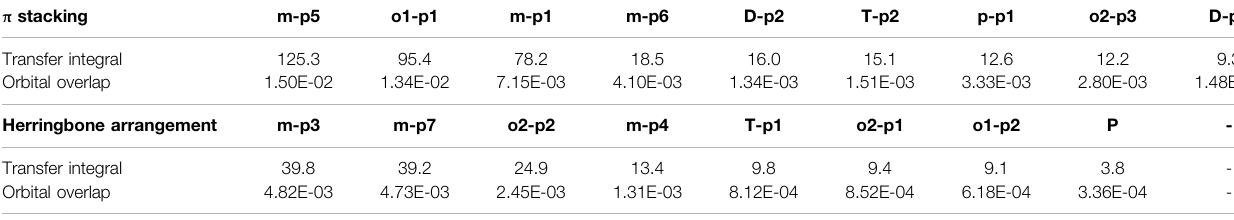
TABLE 2 | Transfer integral and orbital overlap integral of primary electron pathways in π stacking and herringbone arrangement.